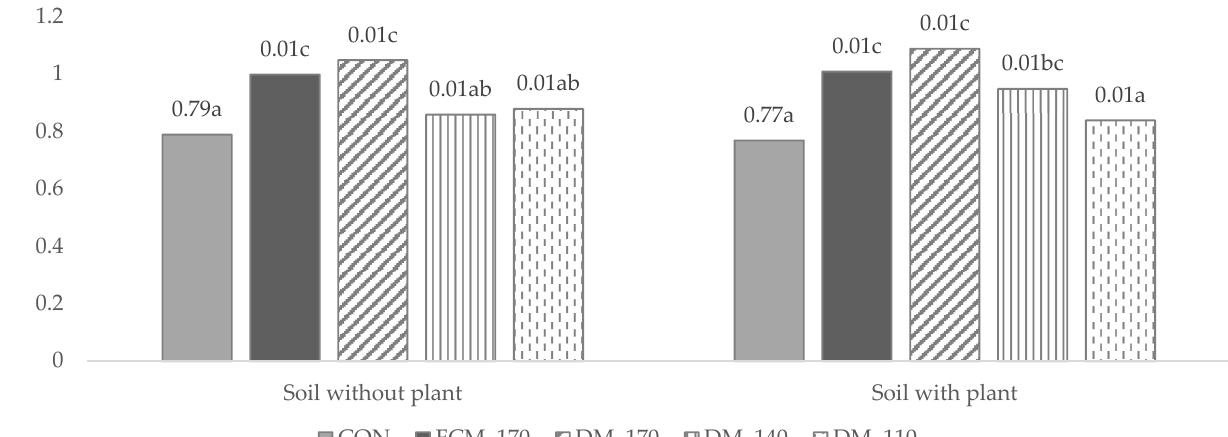
Figure 3. The effect of digestate from liquid cow manure on NH 4 -N in soil leachate. CON—control, FCM_170—Liquid cow manure N 170 , DM_170—Digestate N 170 , DM_140—Digestate N 140 , DM_110— Digestate N 110 . Values followed by different letters are significantly different ( p ≤ 0.05) based on Fisher’s LSD